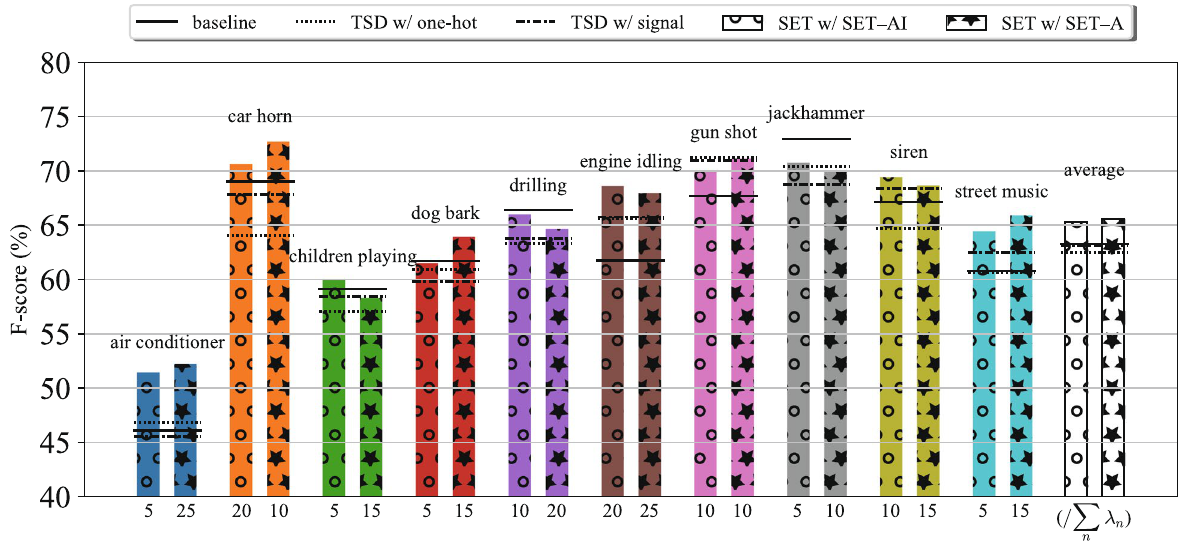
Fig. 5 SET results in terms of frame-based F -score (%) for target